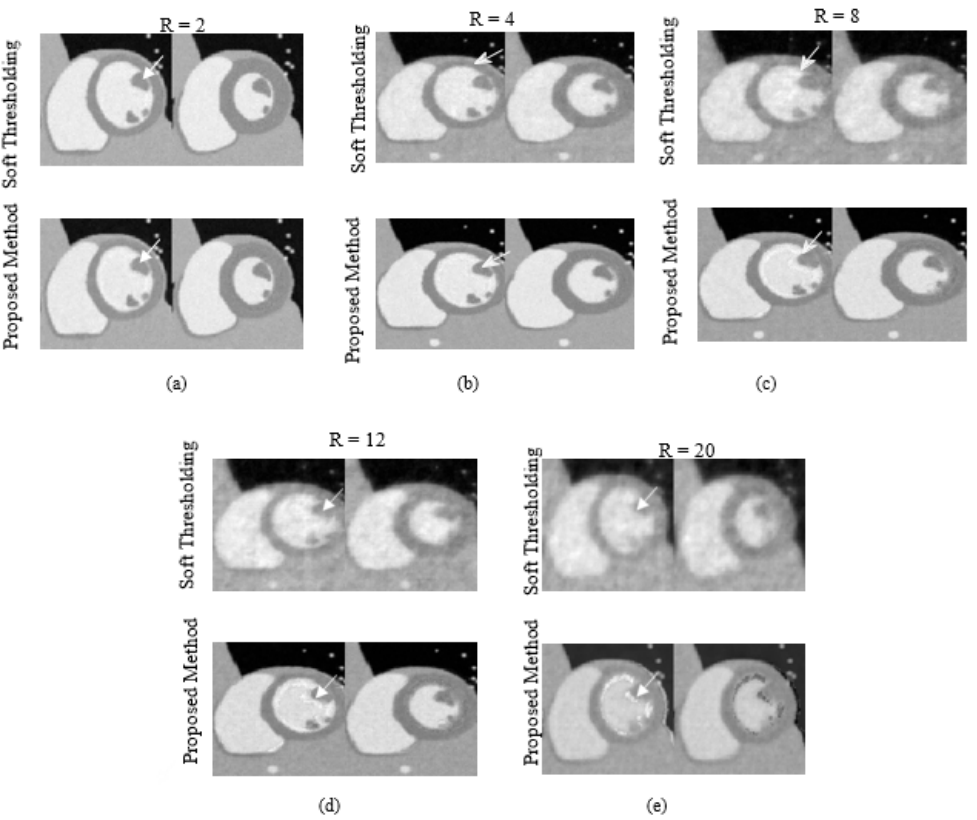
Figure 12. Simulated data ( a ) Compares proposed method at bottom row with IST at top row with acceleration rate of 2. The arrow in ( a ) depicts the very minute presence of artifacts. Here ( b ) depicts the performance of proposed method at acceleration rate equal to 4. The arrow in ( b ) depicts the presence of artefacts ( c ) shows the results of both algorithms with acceleration rate set at 8. ( d ) depicts the results when acceleration rate is set at 12. These artefacts are visible in the IST as mentioned by the white arrow in the figure ( e ) shows very much degraded image quality of IST, while comparing it with the proposed method.